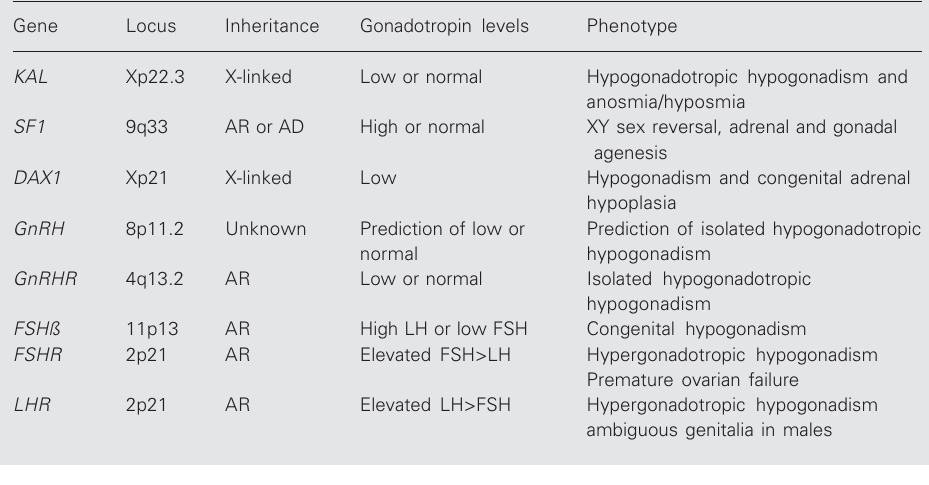
Table 1. Single gene disorders causing impaired gonadal development and function.